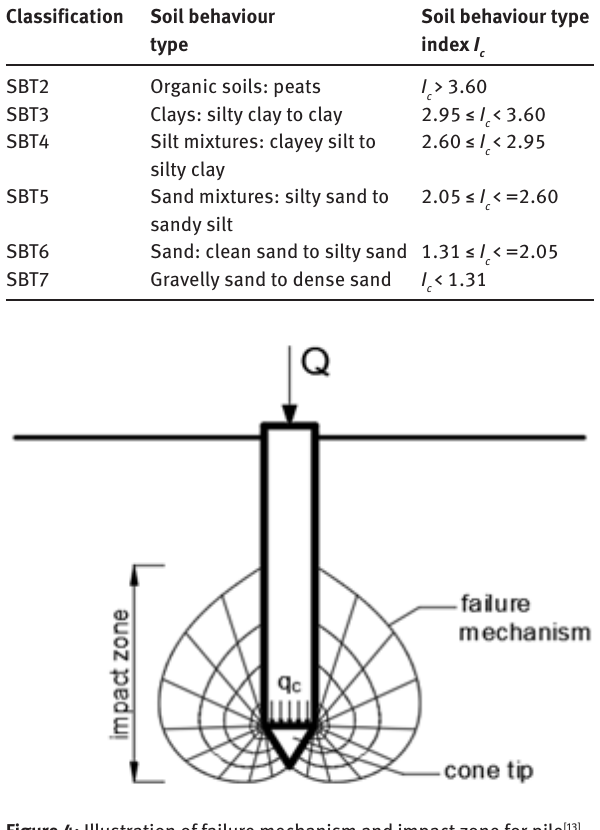
Figure 4: Illustration of failure mechanism and impact zone for pile [13]